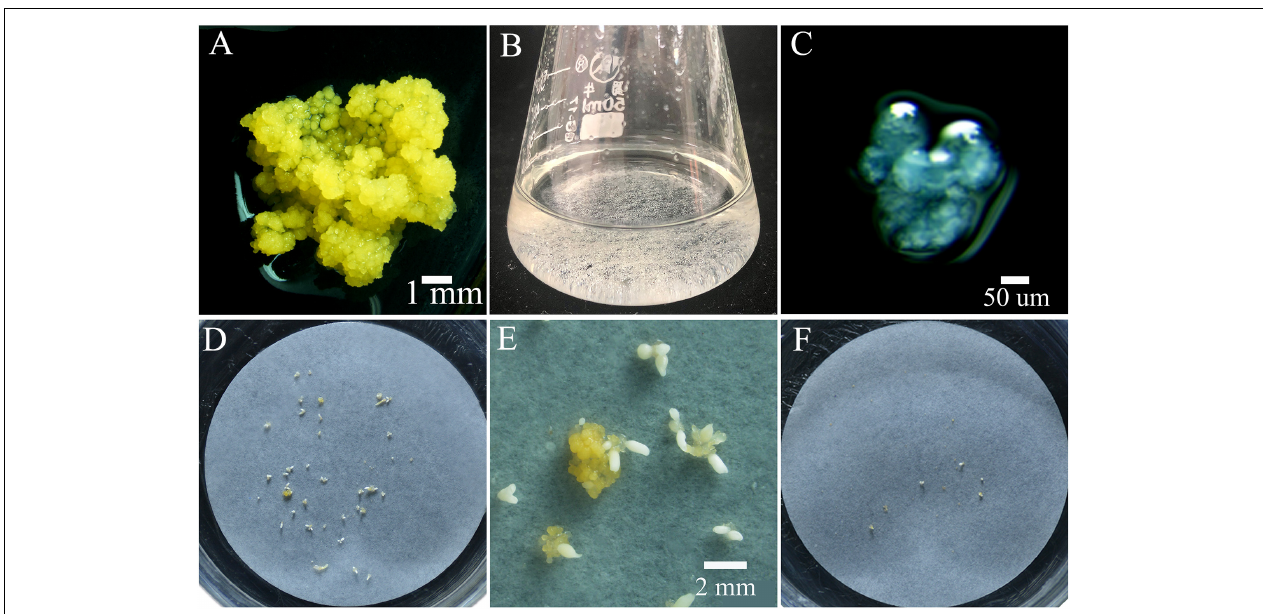
FIGURE 3 | Proembryonic masses (PEMs) and ECAs of Magnolia officinalis used for polyploid induction by colchicine. (A) PEMs of M. officinalis 14 days after subculture. (B) ECAs with a diameter of 100–200 µ m suspended in M3 liquid medium in a 50 mL Erlenmeyer flask. (C) Microscopic observation of the ECAs with a diameter of 100–200 µ m. (D) Somatic embryo differentiation from ECAs plated on a piece of filter paper after 4 weeks culture on M4 medium. (E) A magnified view of somatic embryo differentiation from ECAs plated on a piece of filter paper on M4 medium. (F) Regrowth and somatic embryo differentiation of ECAs treated with colchicine, 4 weeks after colchicine treatments.